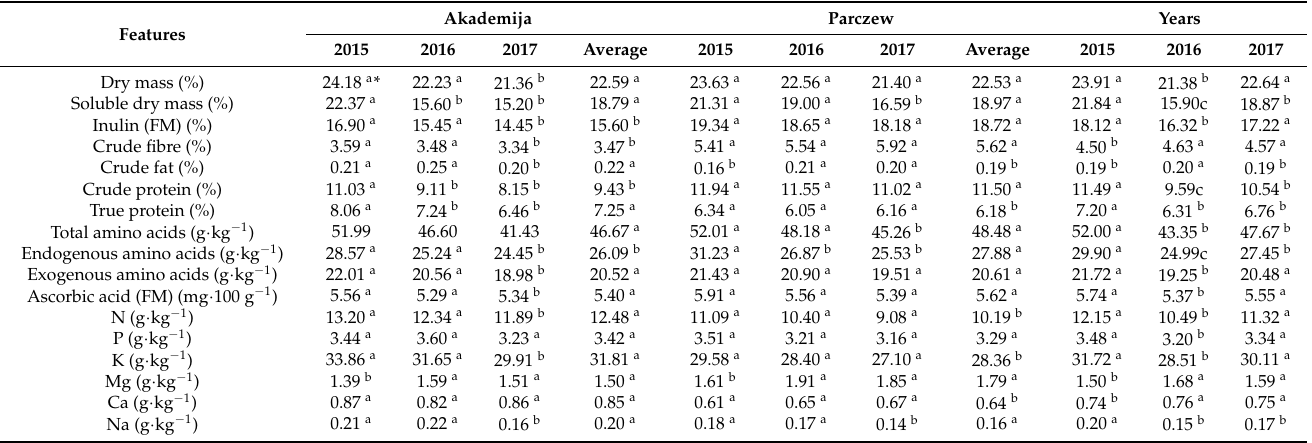
crude fat, and magnesium than the ‘Albik cultivar’. Only calcium content was independent of the varietal characteristics (Table 4). Table 5. Influence of locality and years on the chemical composition of H. tuberosus tubers (average of varieties). Features Dry mass